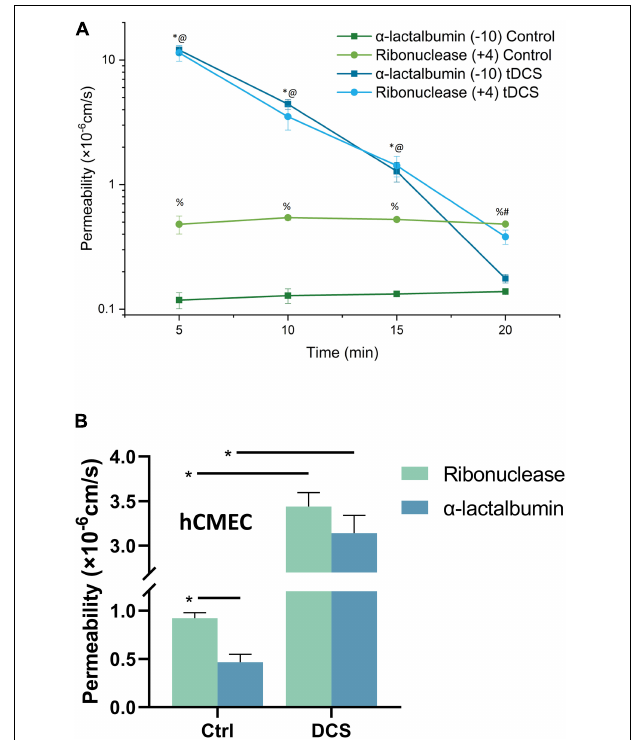
FIGURE 2 | Effects of DCS on the BBB permeability (P) to charged solutes with similar size but opposite charge. (A) Comparison of in vivo BBB P to FITC-ribonuclease (+4) and that to FITC- α -lactalbumin (–10) under control and 5, 10, 15, 20 min after 20 min 1 mA (8 mA/cm 2 ) -tDCS treatment. *, @ p < 0.05, compared with the corresponding controls at the same time; % p < 0.05 comparing P to FITC-ribonuclease with that to FITC- α -lactalbumin under control; # p < 0.05 comparing P to FITC-ribonuclease and that to FITC- α -lactalbumin 20 min post tDCS; n = 6 for each case. (B) Comparison of in vitro BBB P to FITC-ribonuclease and that to FITC- α -lactalbumin under control and after 10 min 1 mA/cm 2 -DCS treatment. * p < 0.05. The in vitro BBB was formed by hCMEC monolayer. n = 7 for the control of ribonuclease, n = 6 for all other